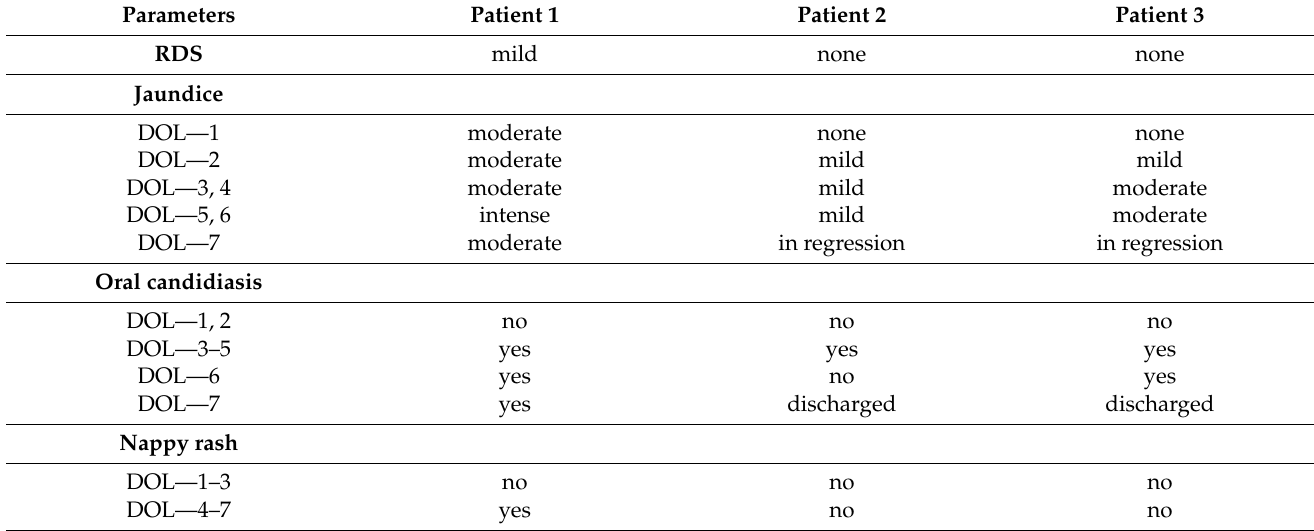
Table 2. Clinical findings.